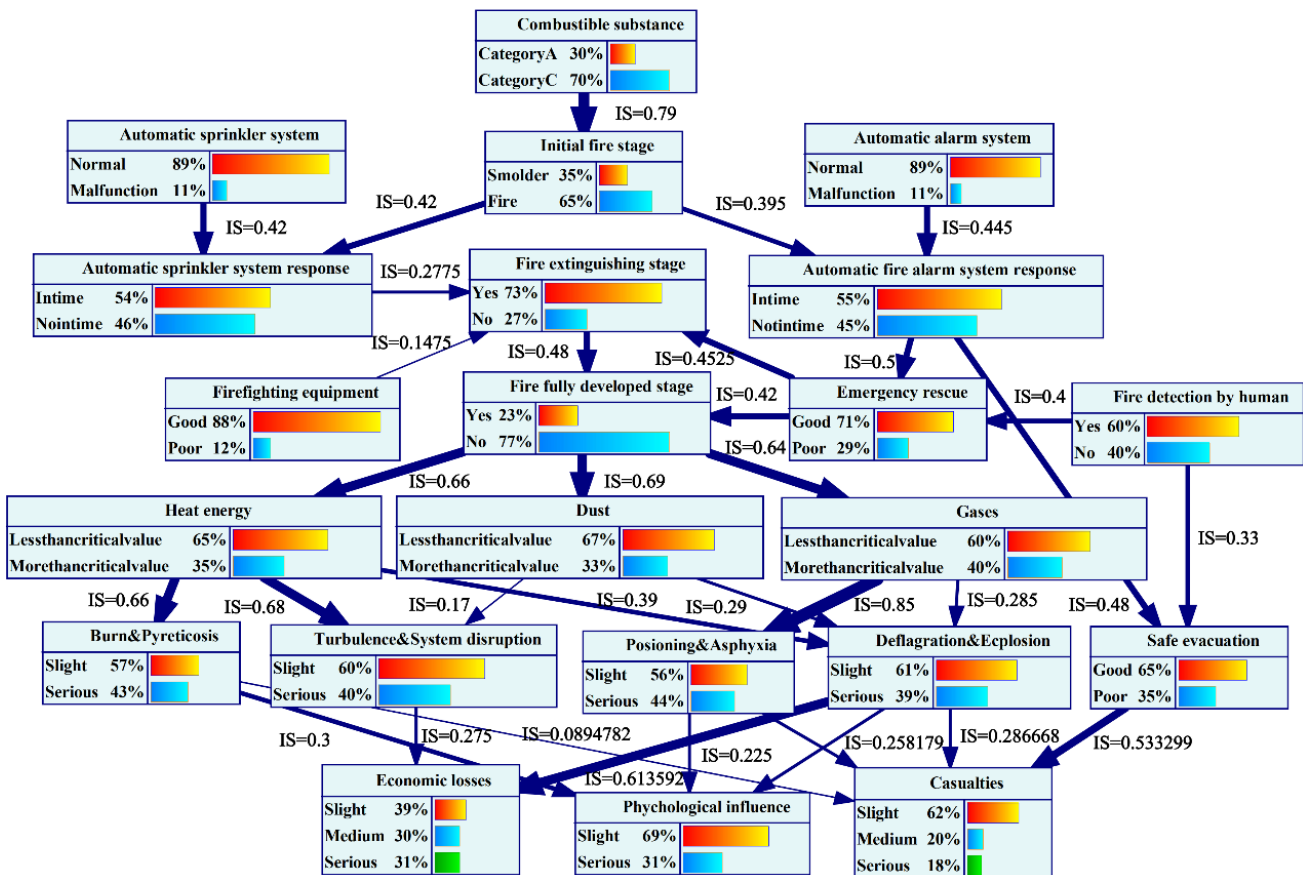
Figure 7. The BN of UEF.